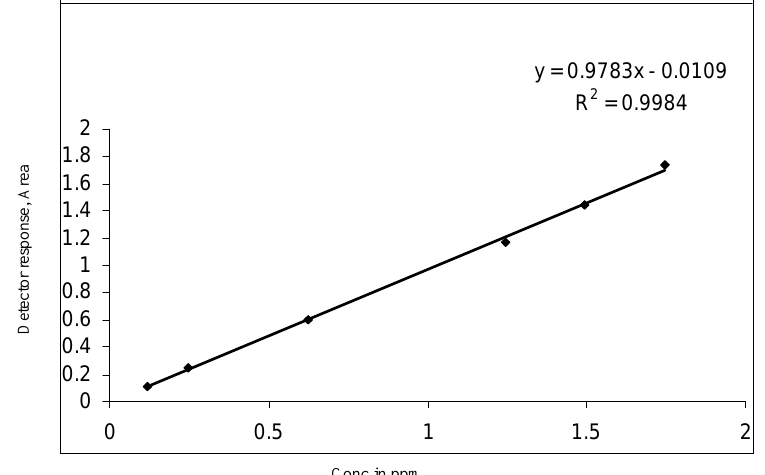
Figure 3. Linearity graph of lenalidomide